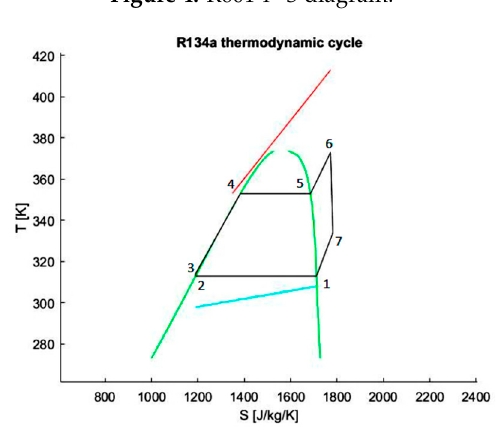
Int. J. Turbomach. Propuls. Power 2019 , 4 , x FOR PEER REVIEW Figure 5. R134a T – S diagram. Figure 5. R134a T – S diagram. Table 3. R134a thermodynamic parameters.